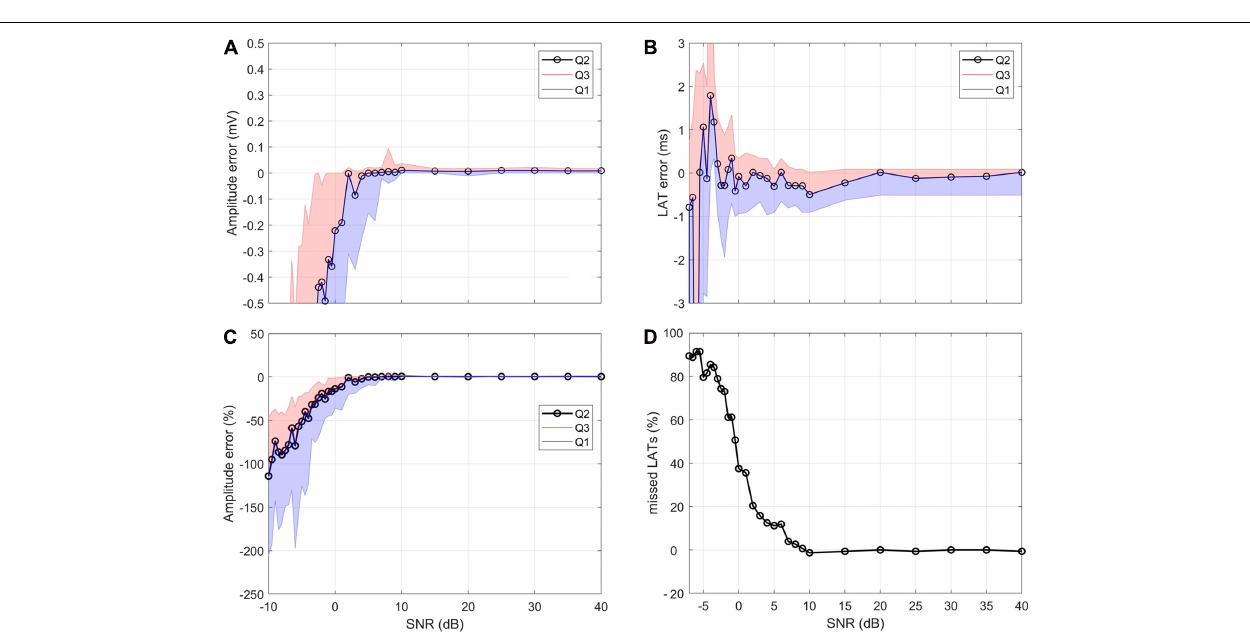
FIGURE 5 | (A) Ground truth amplitude of atrial activity for all channels (blue) and pipeline outcome amplitudes (red). (B) Ground truth propagation speed (blue) and pipeline outcome propagation speed (red). Both panels represent an almost noise-free case (SNR 40 dB). (C) Schematic sketch of bipolar channel arrangement mimicking a clinical case resulting from 10 electrodes.